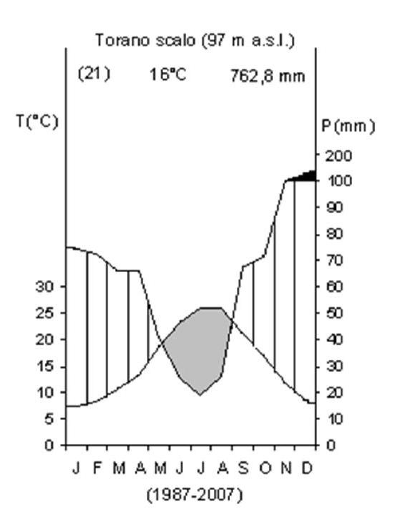
Figure 2. Climate diagram of Torano Scalo meteorological station.